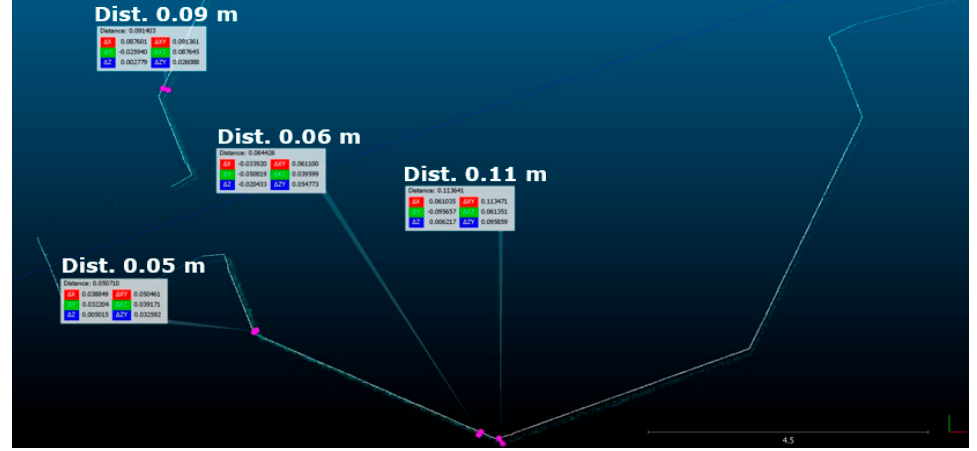
Figure 12. Leica Pegasus Backpack, path 1. Horizontal section of the octagonal vault.